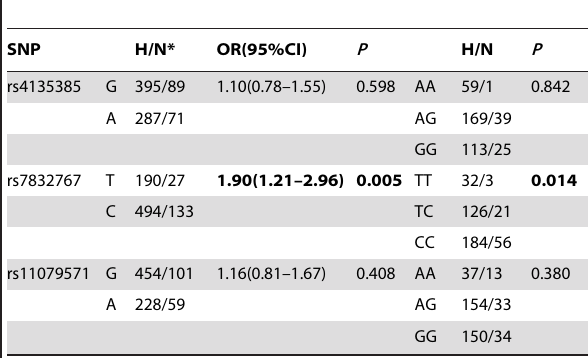
Table 5. Comparison of SNPs in high CRP group versus normal CRP